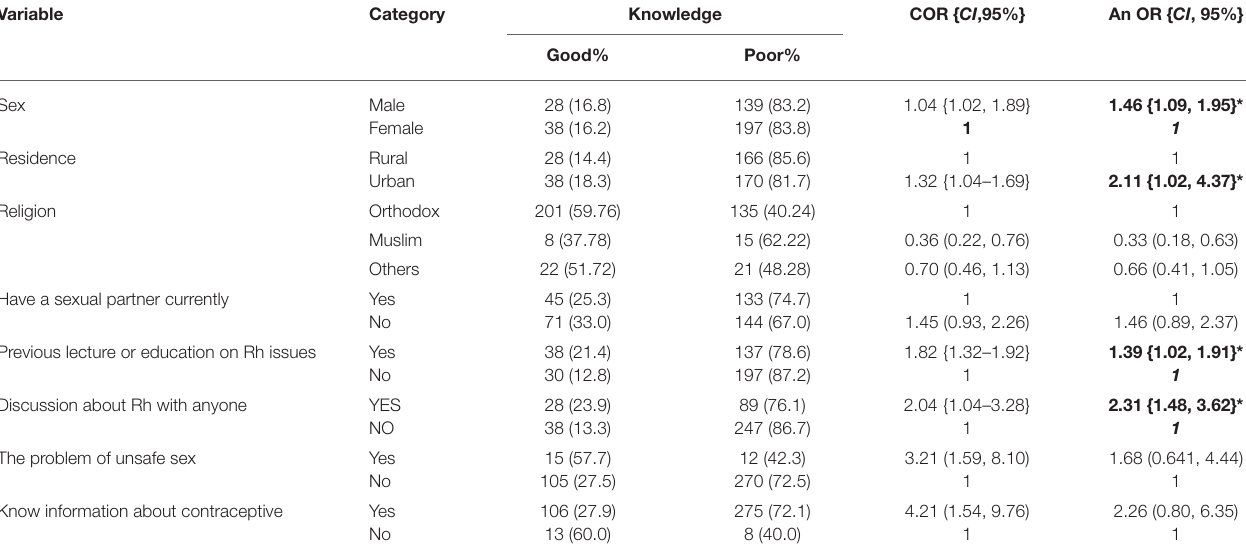
TABLE 2 | Knowledge of sexual and reproductive health rights about factors associated with participants at Aksum University, Northwest Ethiopia, 2018/2019.